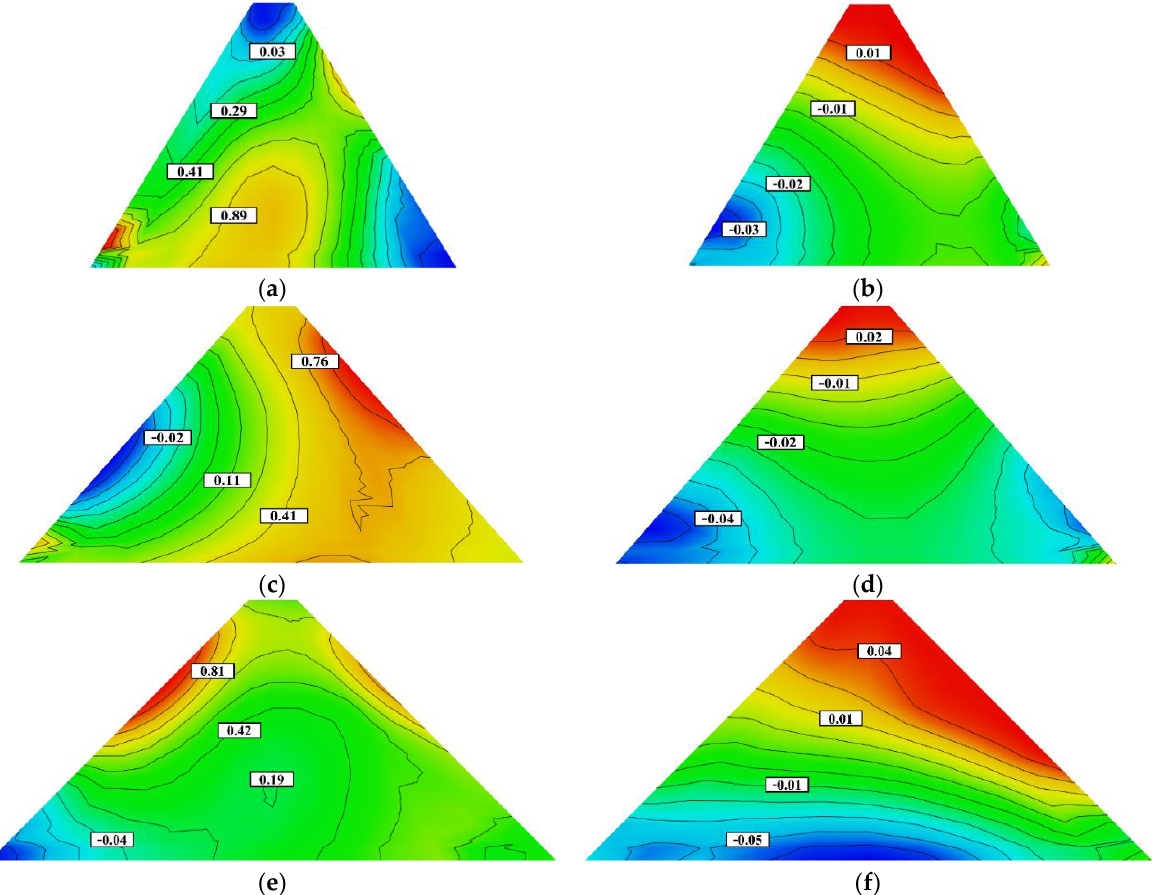
Figure 12. Results of FE analysis (stress distributions). ( a ) Compressive stress of Hachinohe wave (1:0.6); ( b ) tensile stress of Hachinohe wave (1:0.6); ( c ) compressive stress of Ofunato wave (1:0.8); ( d ) tensile stress of Ofunato wave (1:0.8); ( e ) compressive stress of artificial seismic wave (1:1.0); ( f ) tensile stress of artificial seismic wave (1:1.0).